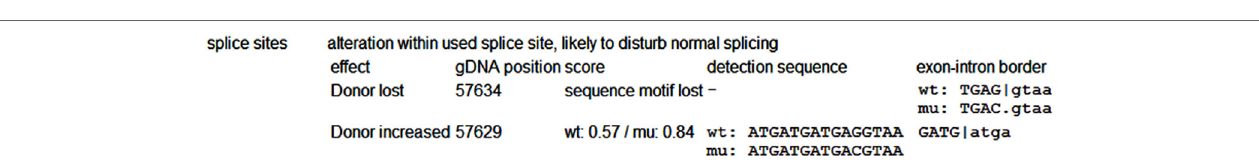
FIGURe 2 | The proband (marked by arrow and confirmed using Sanger sequencing as homozygote for novel mutation) is a boy with cutaneous photosensitivity, severe growth retardation and intellectual disability. Parents have consanguineous marriage, and two of his uncles from mother side had similar phenotype and died around 16 and 17 years. The proband sister is a known case of Down syndrome. By using Sanger sequencing, parents and grandparents from mother side were confirmed as heterozygous carriers of the identified ERCC8 gene mutation and are marked with solid circles with corresponding sequencing chromatograms. Het, heterozygote; Hom, homozygote.